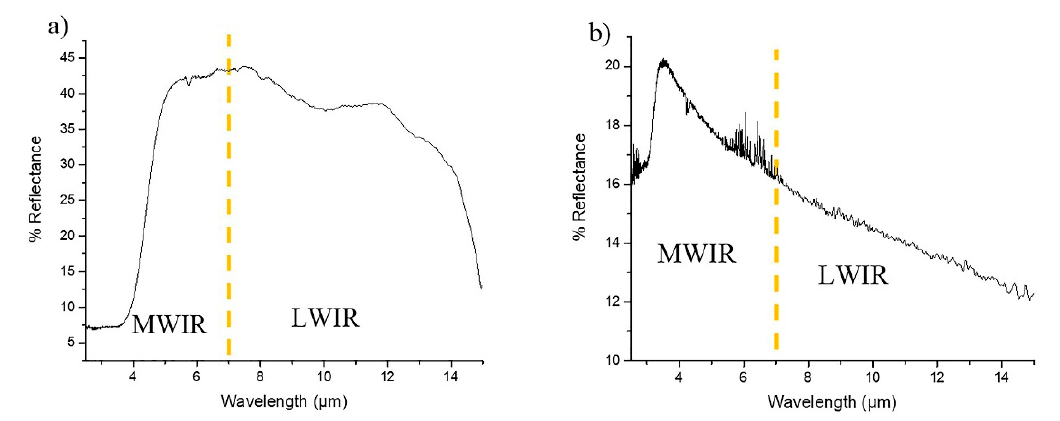
Figure 5. Reflectance spectra of ( a ) sphalerite and ( b ) galena (source: NASA spectra database of minerals [42]).